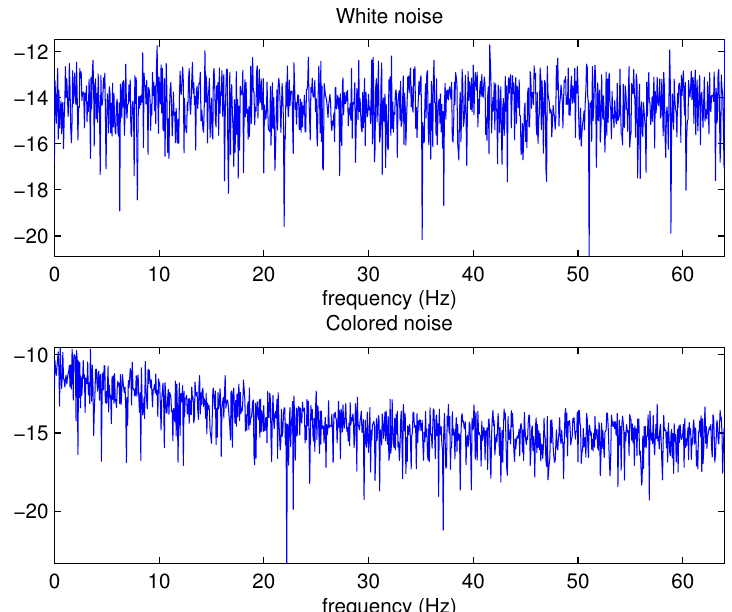
Figure 1. Power spectral densities of white noise and colored